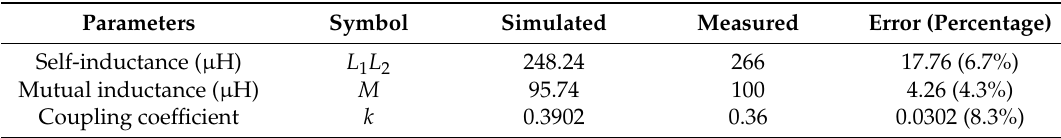
Table 3. Simulated and measured parameters of